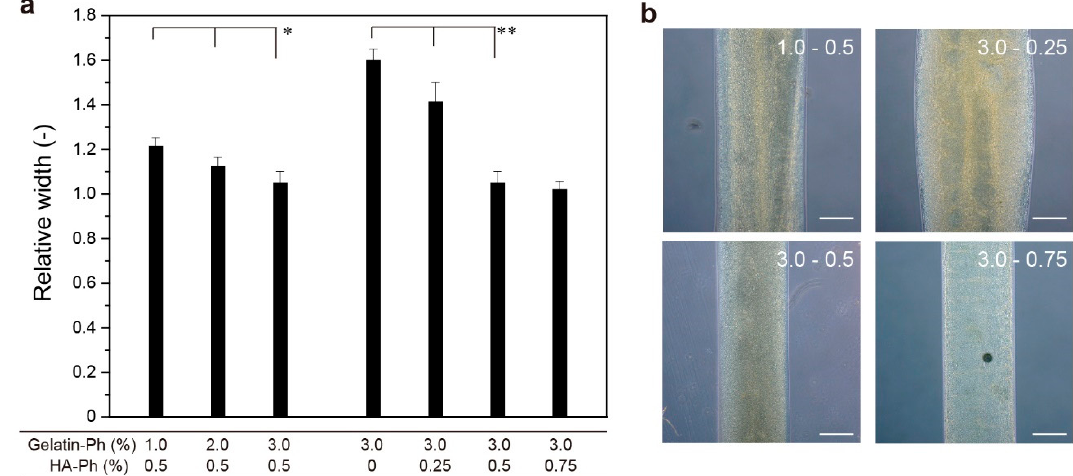
Figure 3. Effects of gelatin-Ph and HA-Ph content on gelation time. Bars: S.D. ( n = 4). * p < 0.05, ** p < 0.01.